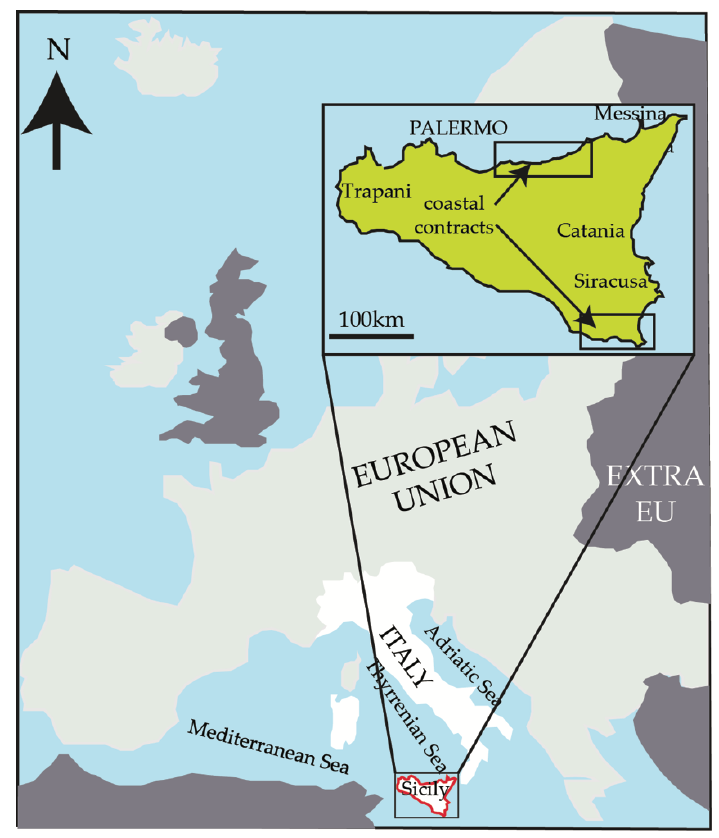
Figure 1. Sicily in the European contest.